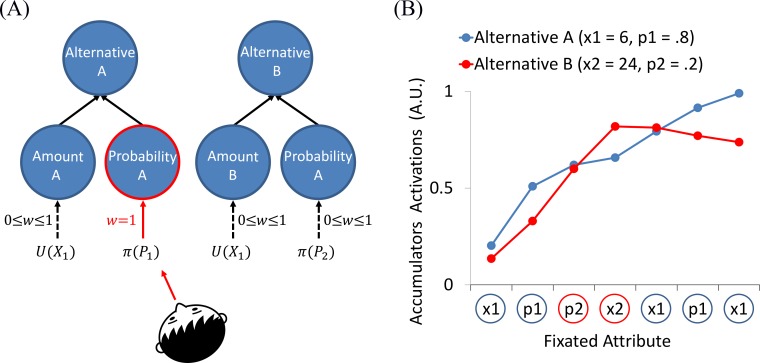
Illustration of the two-layer leaky accumulator model and its dynamics.(A) The first layer consists of four leaky-accumulators associated with the different attributes, and the second consists of two leaky accumulators associated with the alternatives’ values. The units in the first layer are updated with the attentionally modulated subjective values of each attribute (the red arrow indicates the input from the attended attribute, whereas the black arrows indicate the attenuated inputs from the unattended attributes). The units in the second layer are fed with the first layer units' activations, and accumulate their product. (B) Simulated run of the two-layer leaky accumulators model using the average best fitted parameters (see S2 Table), in a choice between: A($6, .8) and B($24, .2); A-wins. Blue circles (x-axis) correspond to fixation toward A, and red circles correspond to fixation toward B. Values on the y-axis correspond to the activations of the second-layer accumulators.